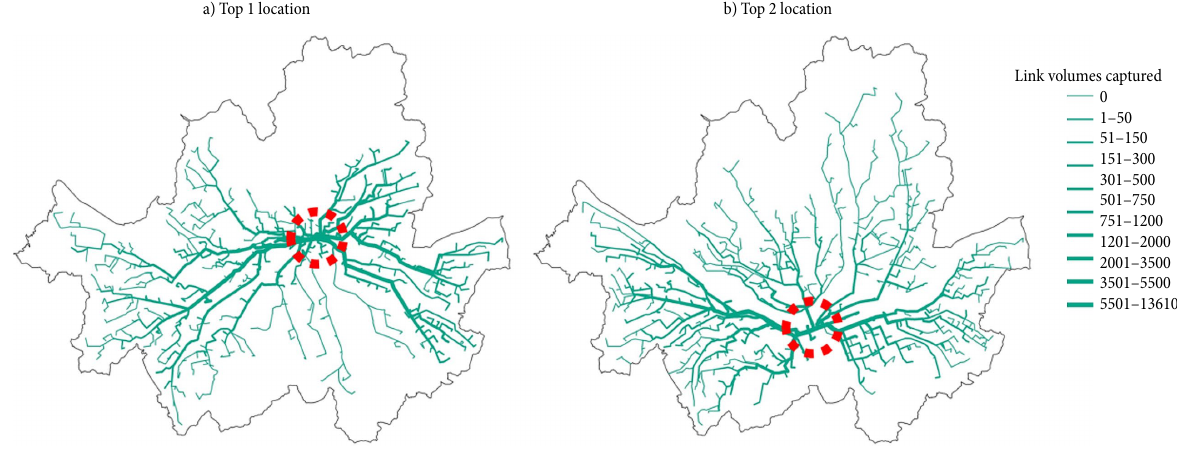
Link volumes captured